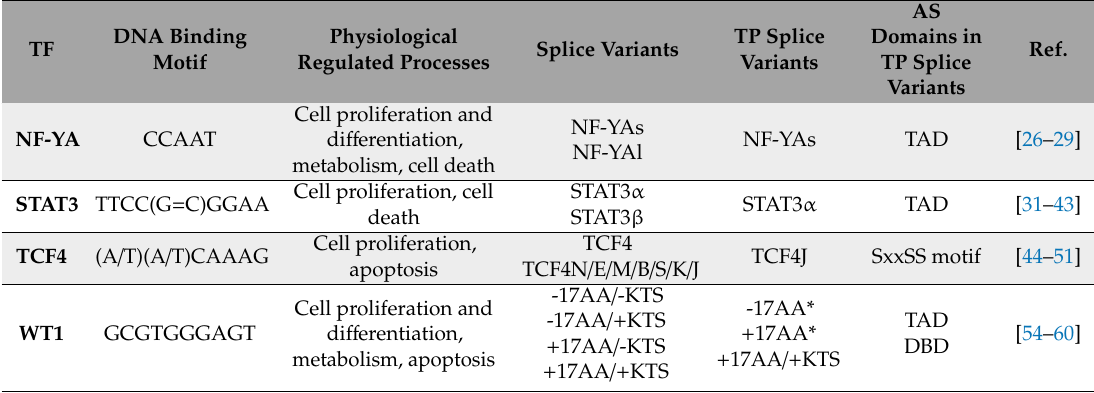
Table 1. Transcription factors (TFs) and respective splice variants that promote tumor formation or growth through direct regulation of specific transcriptional programs. Tumor-promoting (TP) splice variants with clinical correlation data and relative AS domains have been listed. *These isoforms